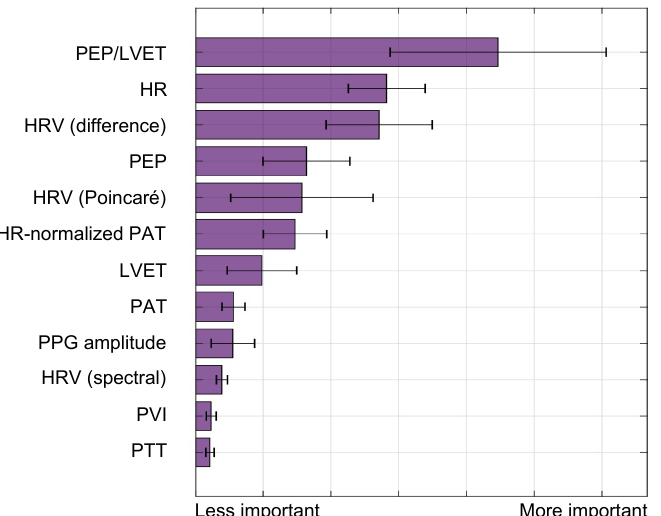
Figure 12. Feature importance for the BVDS model, as output by the random forest algorithm in [12]. Electromechanical features include the pre-ejection period (PEP), left ventricular ejection time (LVET) and their ratio, PEP/LVET along with heart rate (HR) and multiple measures of heart rate variability (HRV). Vascular features include the distal (and normalized) pulse arrival time (PAT), the distal pulse transit time (PTT), the PPG amplitude and the plethysmograph variability index (PVI). PEP/LVET is the most important feature for this model by a large margin, and six of the top seven features are from an electromechanical signal. This result highlights the relevance of including the ECG and SCG signals in predicting cardiovascular decompensation. Image modified from [12].